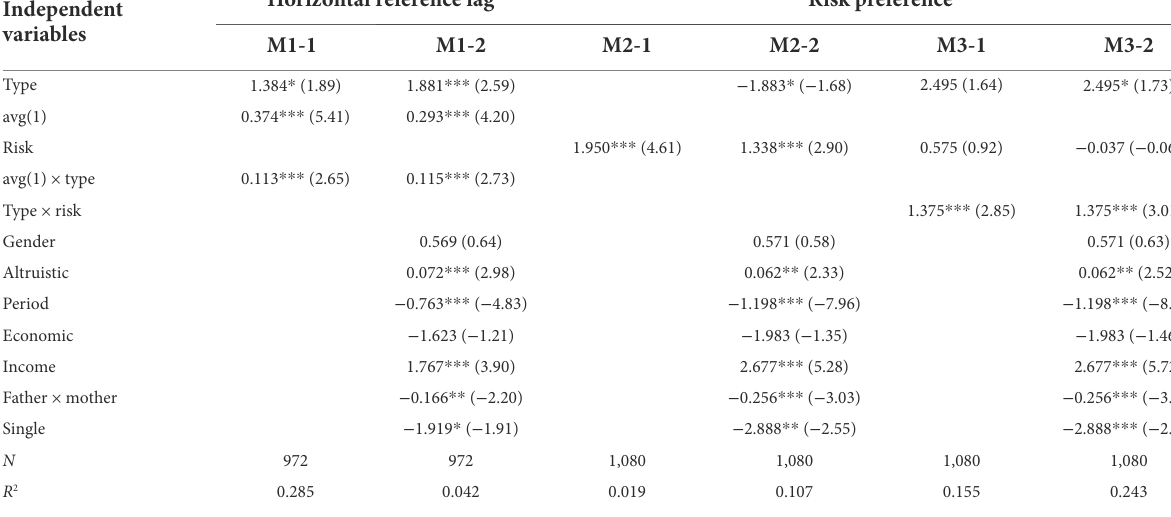
TABLE 9 Horizontal reference point of investment, risk preference and individual investment with